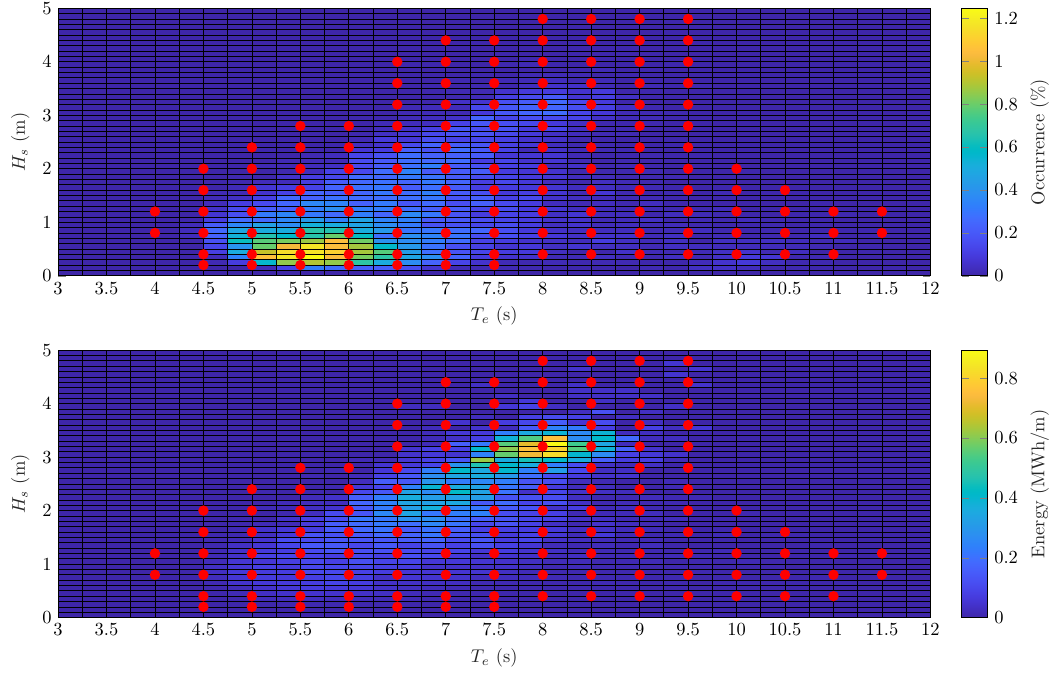
Figure 4. Occurrences and energy scatter diagrams for the installation site close to Pantelleria island, Italy; 128 representative waves were selected for the productivity estimation, shown by the red markers, where the occurrence percentage is not